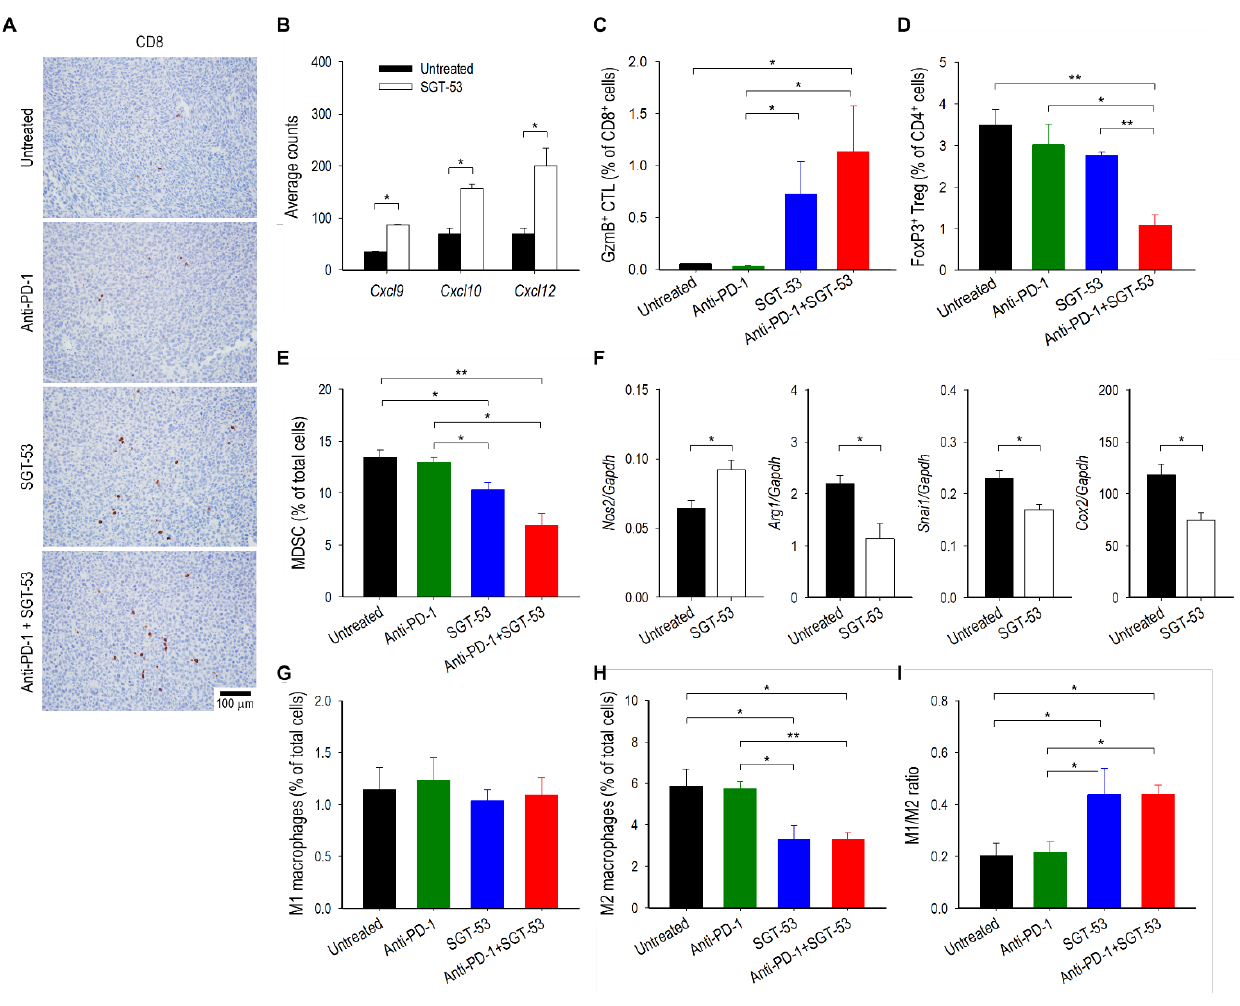
Figure 4. Treatment of anti-PD-1 and SGT-53 enhances host immune responses. Mice with LL/2 tumors were treated with anti-PD-1 (200 µg), SGT-53 (30 µg DNA), or the combination of both agents. ( A ) IHC examination of tumors. Representative staining of CD8 is shown. ( B ) Changes in expression of chemokines related to T cell migration were assessed using NanoString analysis. Tumor-infiltrating immune cells including ( C ) CTLs (CD45 + CD3 + CD8 + GzmB + ), ( D ) Tregs (CD45 + CD3 + CD4 + FoxP3 + ) and ( E ) MDSCs (CD45 + CD11b + Gr1 + ) were assessed via flow cytometry. ( F ) Expressions of genes associated with macrophage polarization in the whole tumor were assessed by RT-qPCR. Quantifications of populations of ( G ) M1 macrophage (CD45 + CD11b + F4/80 + CD11c + ) and ( H ) M2 macrophage (CD45 + CD11b + F4/80 + CD206 + ) in tumor using flow cytometry. ( I ) The ratio of M1/M2 macrophages. Data are presented as mean ± SEM and were analyzed by one-way ANOVA or Student’s t test. * p < 0.05, ** p < 0.001. n = 5 – 10/group. Flow cytometry gating strategy and repre-